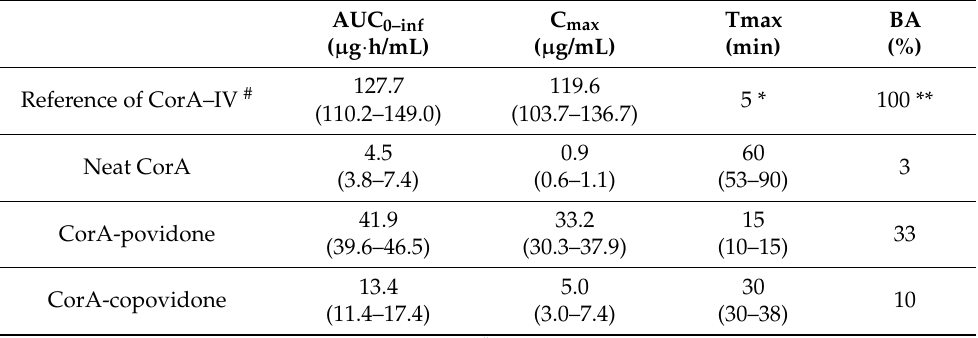
Figure 4. CorA plasma concentration time profiles in BALB/c mice: ( A ) IV administration of a CorA- solution (36 mg/kg) (Data from Ref. [14]); ( B ) PO administration of neat CorA ( ■ ), CorA-povidone ( ● ) and CorA-copovidone ( ▲ ) (36 mg/kg), administered as an aqueous suspension in female BALB/c mice (median ± IQR, n = 4 per group). Table 5. Pharmacokinetic parameters of CorA and CorA formulations after IV administration of a CorA-solution (36 mg/kg) and PO administration of the solid CorA-ASD formulations CorA- povidone and CorA copovidone (36 mg/kg) in female BALB/c mice (median ± IQR, n = 4 per